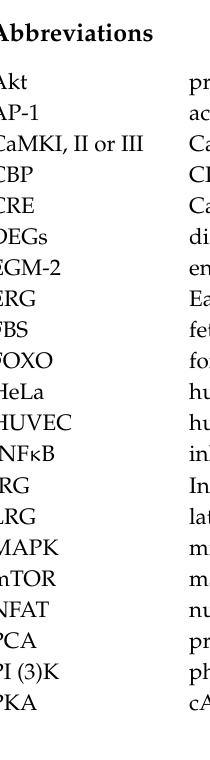
Table S2: Common di ff erentially expressed genes triggered by Na,K-ATPase inhibition by 3 µ M ouabain or K + -free medium in 2h. Table S3: Prediction of G-quadruplexes within early response genes’ DNA. Figure S1: KEGG pathways of di ff erentially expressed genes triggered by Na,K-ATPase inhibition by 3 µ M ouabain (A,C,E,G) or K + -free medium (B,D,F,H) in 0.5 h,1 h, 2 h and 6 h,